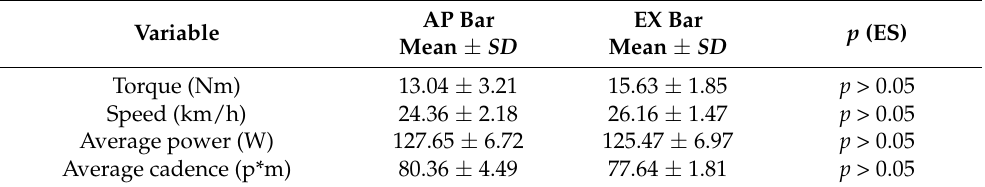
Table 4. Comparison of the performance variables for the Aptonia (AP) and Etixx (EX) bars. The data are expressed as mean values with their standard deviations ( SD s), significances ( p ), and Cohen effect sizes (ES).